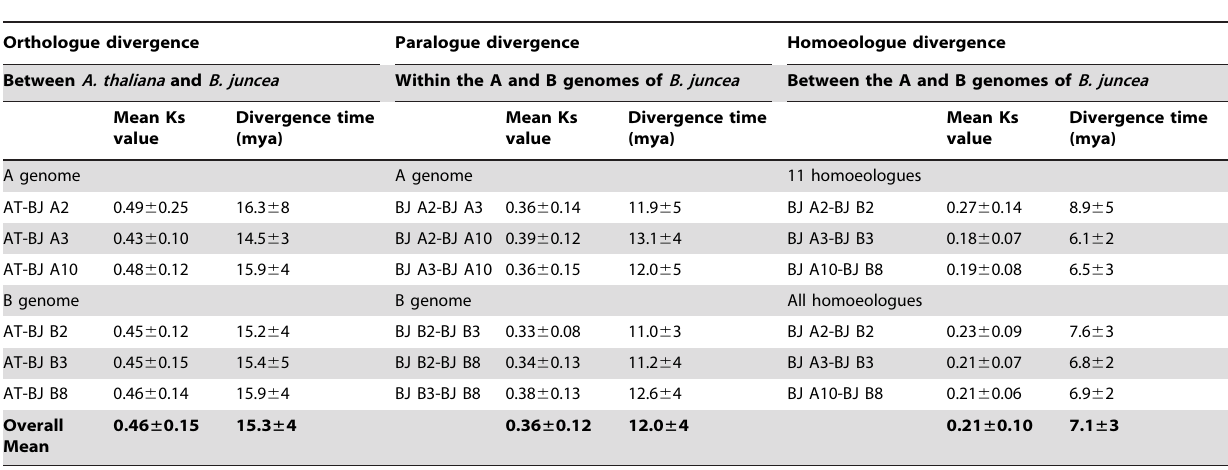
Table 2. Nuclear genome divergence analysis based on synonymous nucleotide substitutions in the genes retained across all the six R blocks of B. juncea and their orthologues from A. thaliana